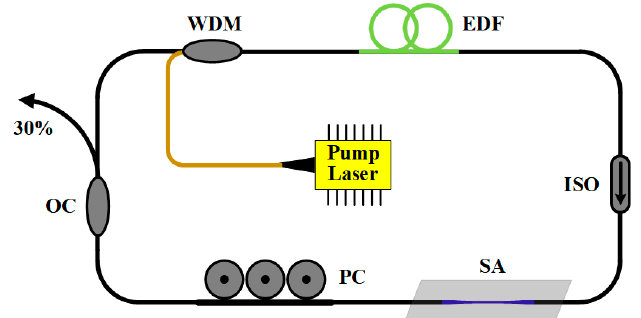
Figure 4. Diagram of erbium-doped fiber mode-locked pulsed laser based on WSe 2 -SA (WDM: wavelength division multiplexer, EDF: erbium-doped fiber, OC: optical coupler, PC: polarization controller, ISO: isolator).